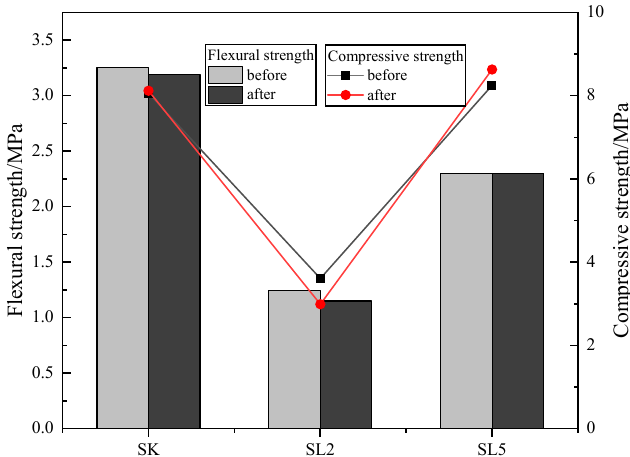
Figure 12. Strength comparison in alkali resistivity experiment.